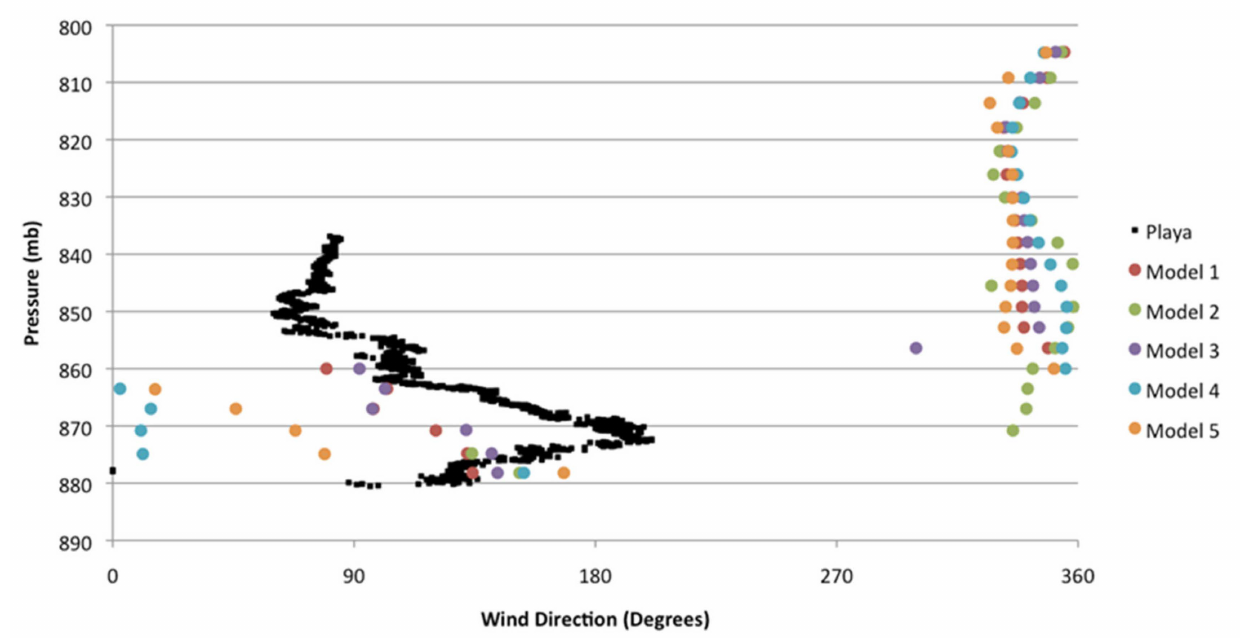
Figure 21. Model upper-air wind direction profile ( ◦ ) shown by pressure level (hPa) for different model experiments vs. tethersonde at 1300 UTC 10-14-2012 at the Playa